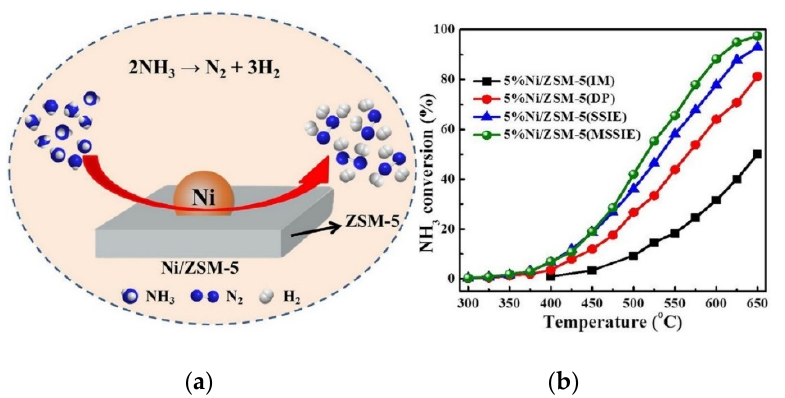
Figure 18. Catalytic ammonia decomposition, ( a ) schematic, ( b ) conversion with temperature. Reprinted with permission [92].